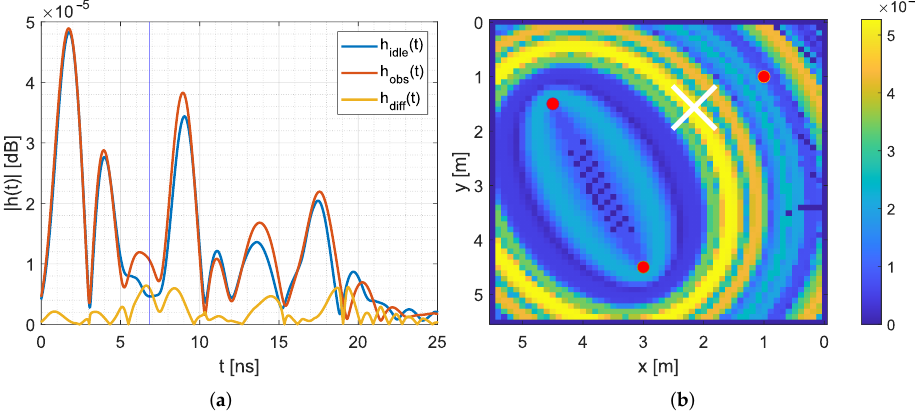
Figure 6. Multi-static radar principle. ( a ) Typical CIR and differences. ( b ) Heat map of MSR for a single sensor